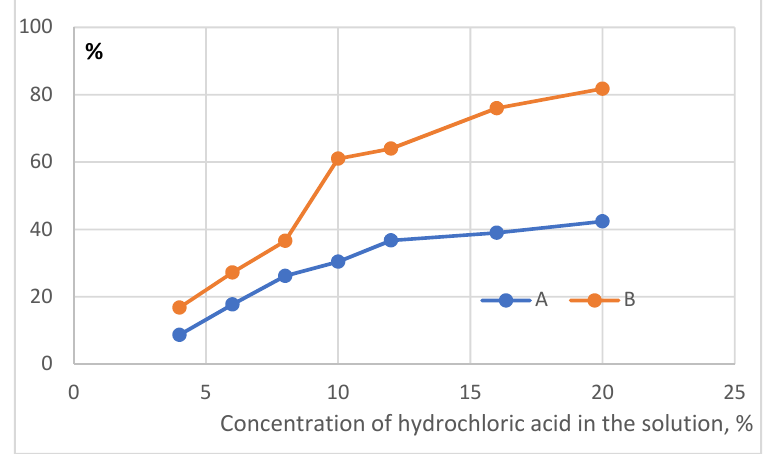
Figure 4. Average Zinc extraction (%) without mechanical activation (A) and with mechanical activation (B).